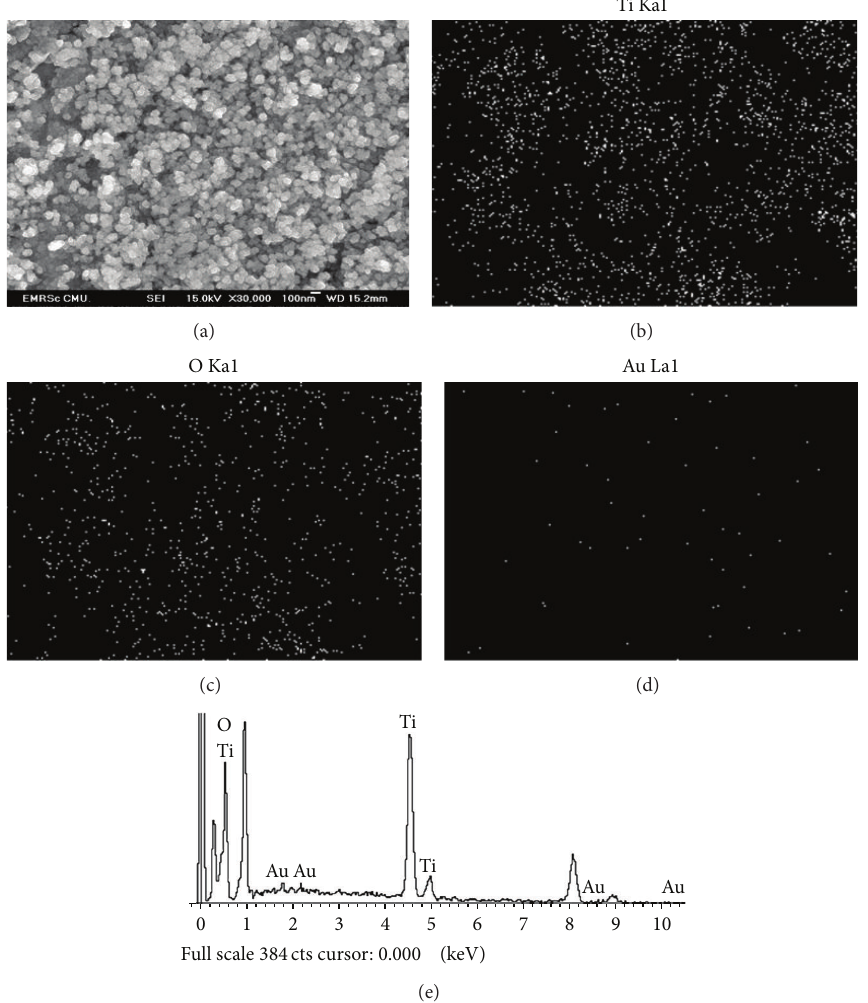
Figure 4: (a) SEM micrographs and EDS mapping mode of (b) Ti, (c) O, (d) Au, and (e) EDS spectra of 1.0 mol% Au-loaded TiO 2 nanoparticles.